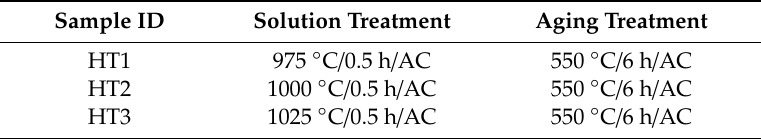
Table 1. Heat treatment of the as-forged 7.5 vol. % TiB whiskers (TiB w )/Ti composite.